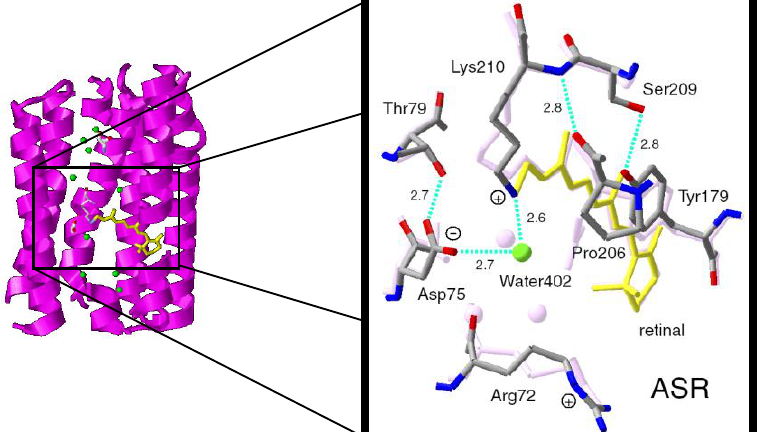
Figure 4. (Left) X-ray crystallographic structure of ASR (1XIO[16]). Purple ribbons, green spheres, yellow and white sticks correspond to helices, water molecules, retinal and amino acid residues, respectively. (Right) The Schiff base region of ASR and BR (translucent structure, 1C3W [7]), respectively. Each retinal molecule between ASR and BR is fitted to compare the hydrogen-bonding networks by using Swiss-PdbViewer [19]. Top and bottom regions correspond to the cytoplasmic and extracellular sides. The green sphere (Water 402) represents a water molecule which forms a hydrogen bond bridge between the protonated Schiff base and its counterion, Asp75. Hydrogen-bonds (blue dashed lines) are inferred from the structure and the numbers are the hydrogen-bond distances in Å. This figure is adapted with permission from Furutani et al. [20]. Copyright 2005 American Chemical